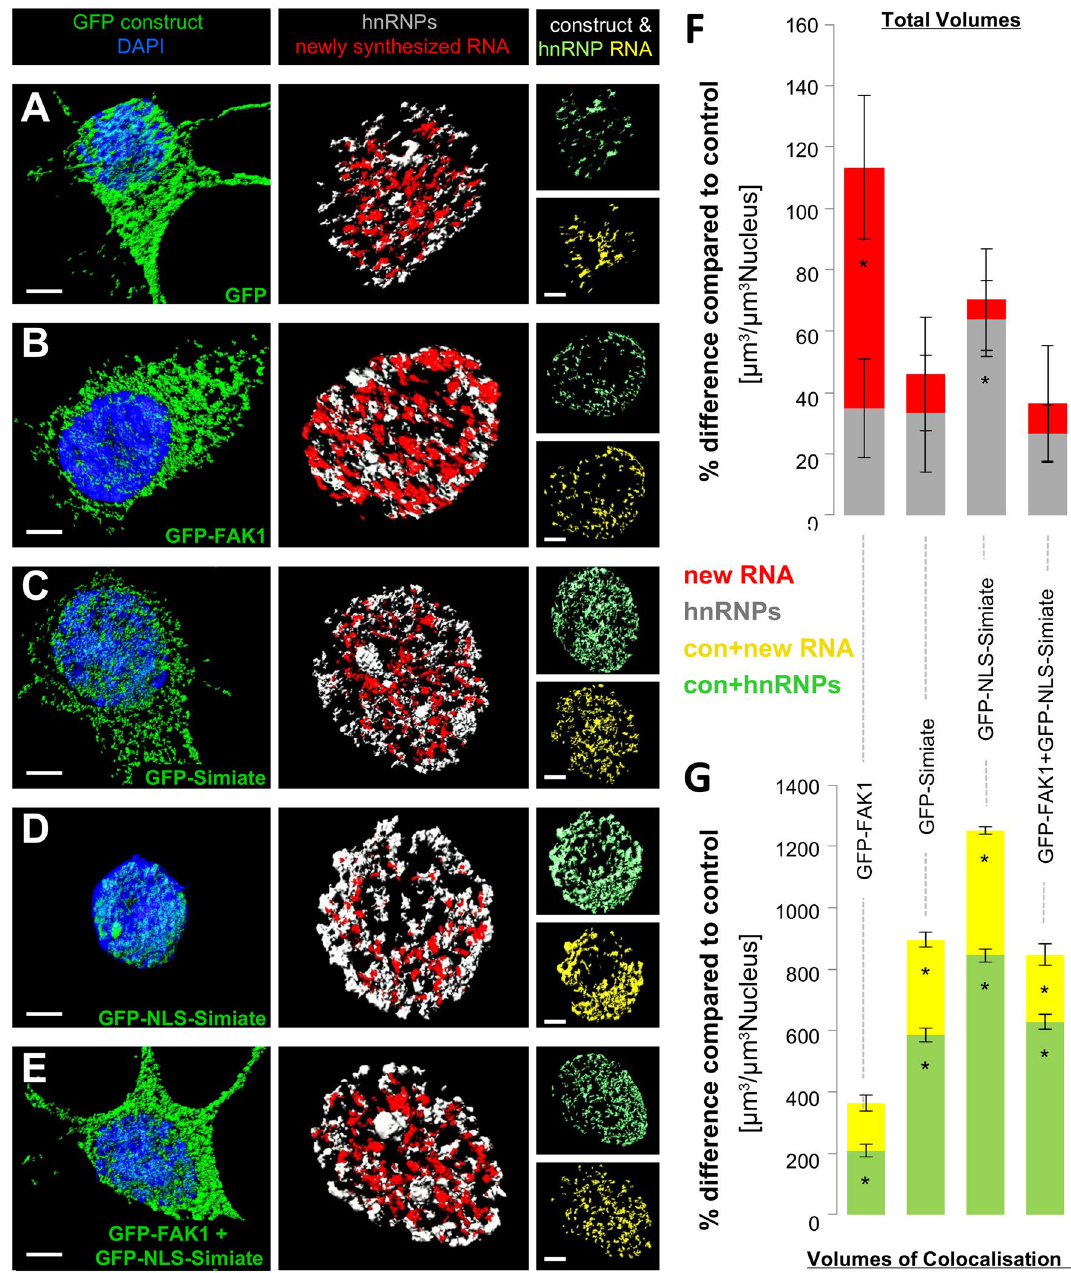
Figure 12. Simiate but not FAK1 affects RNA processing. Recombinant proteins, newly synthesised RNA and hnRNPs, a marker for RNA processing, as well as colocalised proteins were reconstructed 3-dimensionally and quantified in Imaris software. ( A – E ) The pictures show reconstructions of hnRNPs and newly synthesised RNA after enhanced expression of FAK1 and Simiate constructs. Left column: expression of constructs. Middle column: expression of marker proteins. Right column: intersections of the respective GFP construct and marker proteins. ( F , G ) Quantifications of corresponding volumes ( F ) and volumes of colocalisation ( G ) are displayed as deviation from GFP conditions. Again, GFP serves to control for unspecific effects on transcription and splicing activity caused by recombinant expression. GFP: n = 8; FAK1: n = 7; Simiate: n = 8; NLS-Simiate: n = 8; FAK1 + NLS-Simiate: n = 8. Further statistical details are summarised in Suppl. Table 1. Scale bars: 3 µm. Con: construct (GFP-FAK1, GFP-Simiate and GFP-NLS-Simiate). Colour coding: blue—DAPI, green—GFP or GFP construct, grey—hnRNPs, red -newly synthesized RNA; light green—hnRNPs colocalised with GFP constructs, yellow—newly synthesized RNA colocalised with GFP